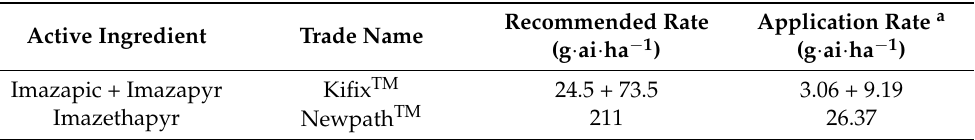
Table 1. Herbicide treatments used in experiments I and II on Echinochloa colona, at low herbicide use rates and salt stress. Both herbicides belong to WSSA Group 2, imidazolinone chemical family, which inhibit acetolactate synthase